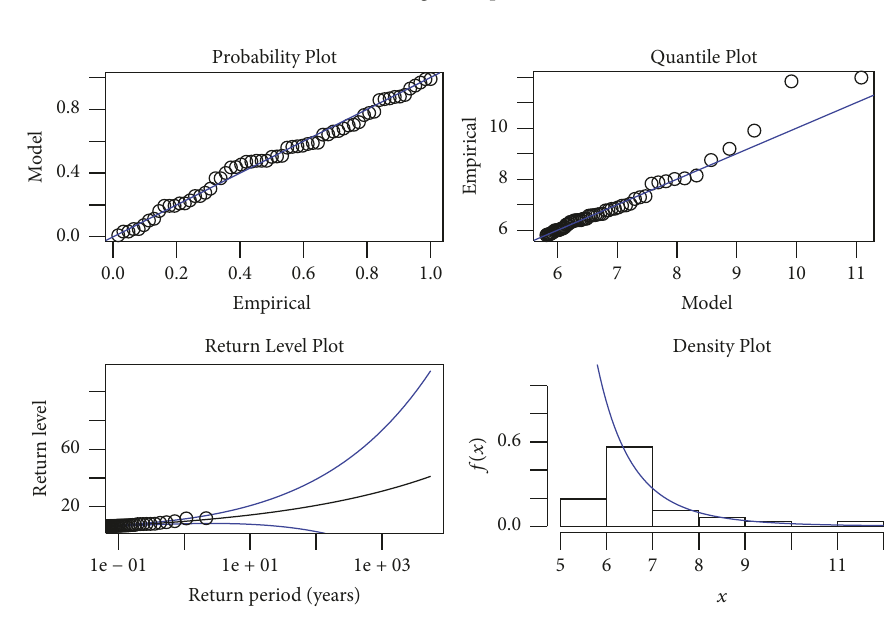
Figure 7: Diagnostic plots of